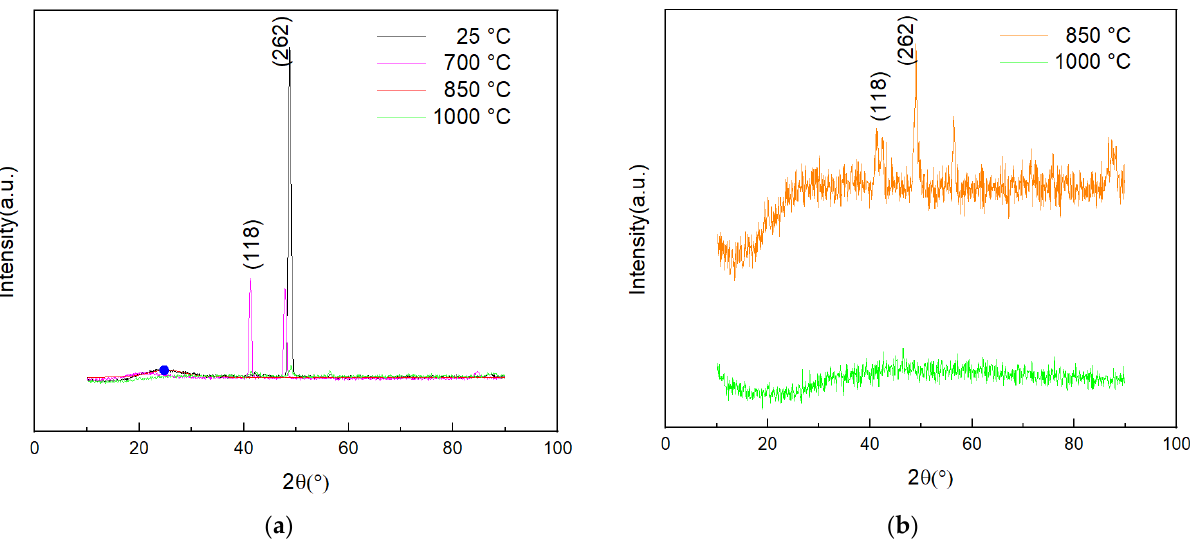
Figure 8. X-ray diffraction patterns for the Bi 3 . 75 La 0 . 25 Ti 3 O 12 coatings. ( a ) All study temperatures, ( b ) details for temperatures of 850 °C and 1000 °C.